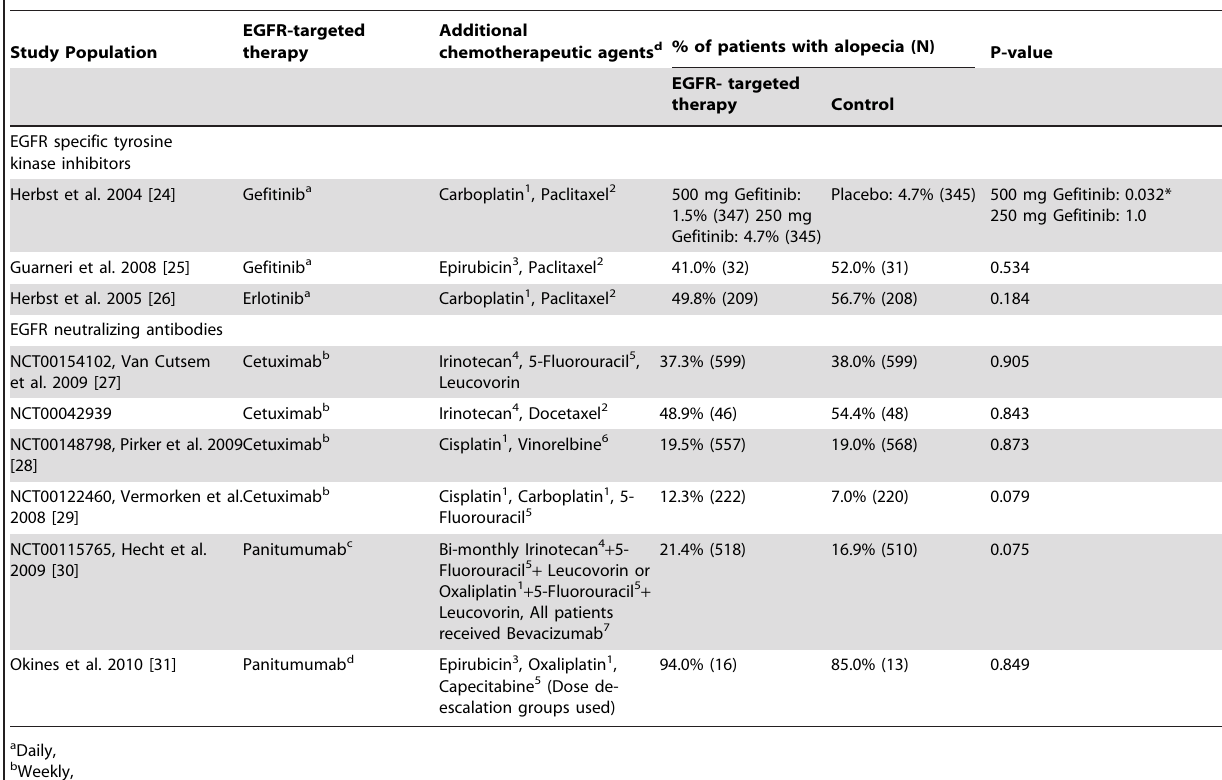
Table 1. EGFR-targeted therapy and alopecia rates during